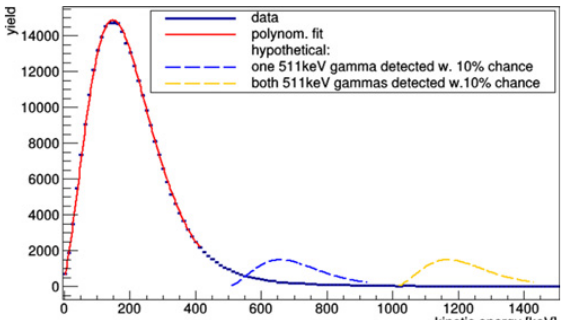
Figure 2. Measurement of a 22 Na positron spectrum in a test set-up with a detector similar to the P ERKEO II detector. The detection probability of a positron annihilation gamma with its full energy of 511 keV is excluded to be larger than 1%.